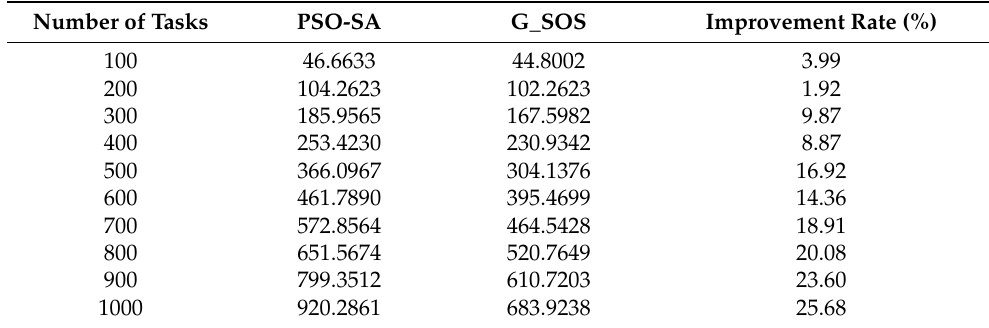
Table 5. Makepan comparison between PSO-SA and G SOS for data instances generated from a uniformly distributed dataset.